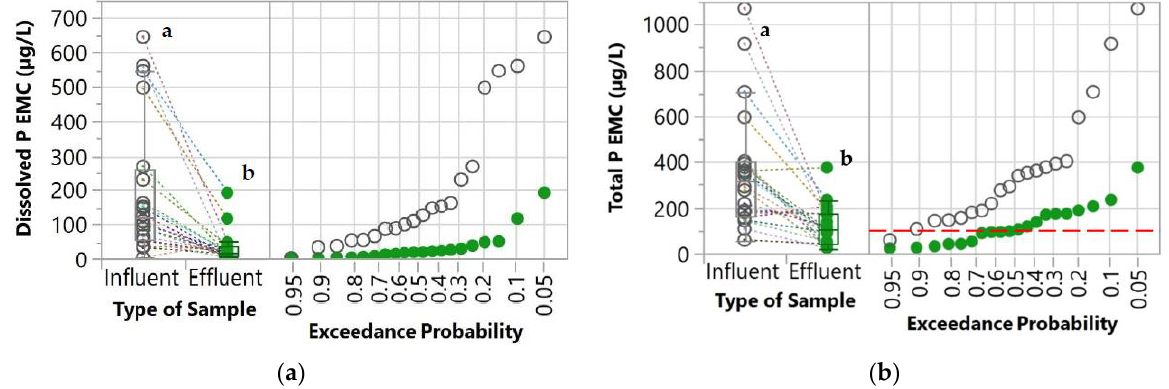
Figure 3. Box plot and normal probability plot of ( a ) dissolved and ( b ) total P EMCs of influent and effluent samples. A pair of influent and effluent EMCs from the same storm event and catch basin are connected with dotted lines. Different lowercase letters (a and b) indicate significant differences between influent and effluent P content ( p < 0.05). The red horizontal dashed line represents water quality goals [34].